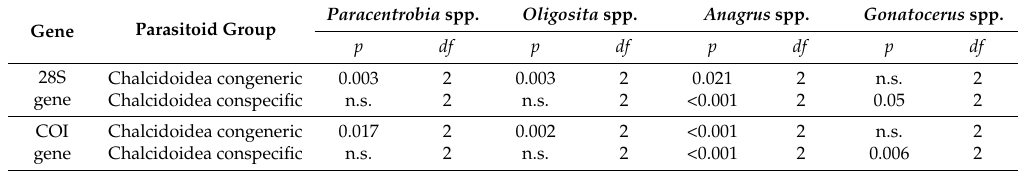
Table 2. Results of the Dunn’s test ( p ) with degrees of freedom ( df ) for pairwise comparison of the pairwise genetic distances calculated within the parasitoid genera examined in this study, and the pairwise genetic differences calculated for the congeneric and conspecific Chalcidoidea sequences (n.s. stands for not